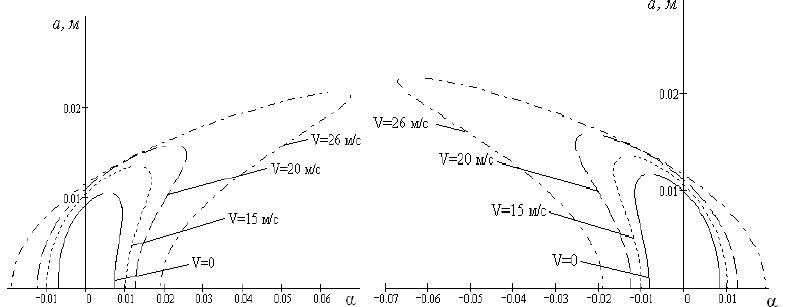
Figure 4. Dependences of the resonant amplitude of vibrations of an elastic body on the frequency unbalance at different values of the nonlinear component of the reducing force: 𝑘 (cid:2870) < 0 , 𝑘 (cid:2870) > 0 . It follows from the above that when the sign of the nonlinear component of the re-